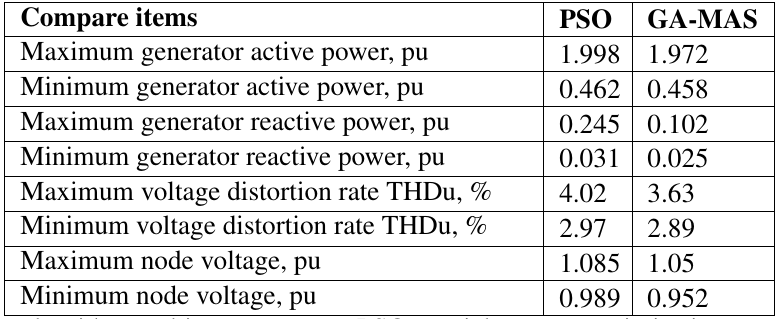
Table 1 Comparison results of different optimisation algorithms Compare items